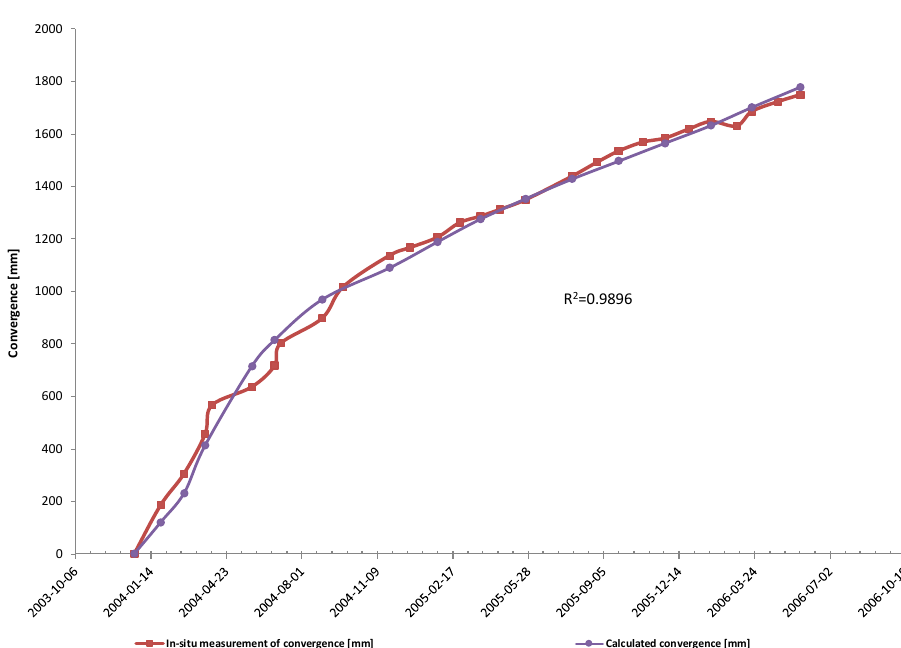
Figure 14. Matching of results of in-situ convergence measurements in Polkowice-Sieroszowice mine to convergence values obtained for effective parameters of pillars determined using statistical methods (elastic model).